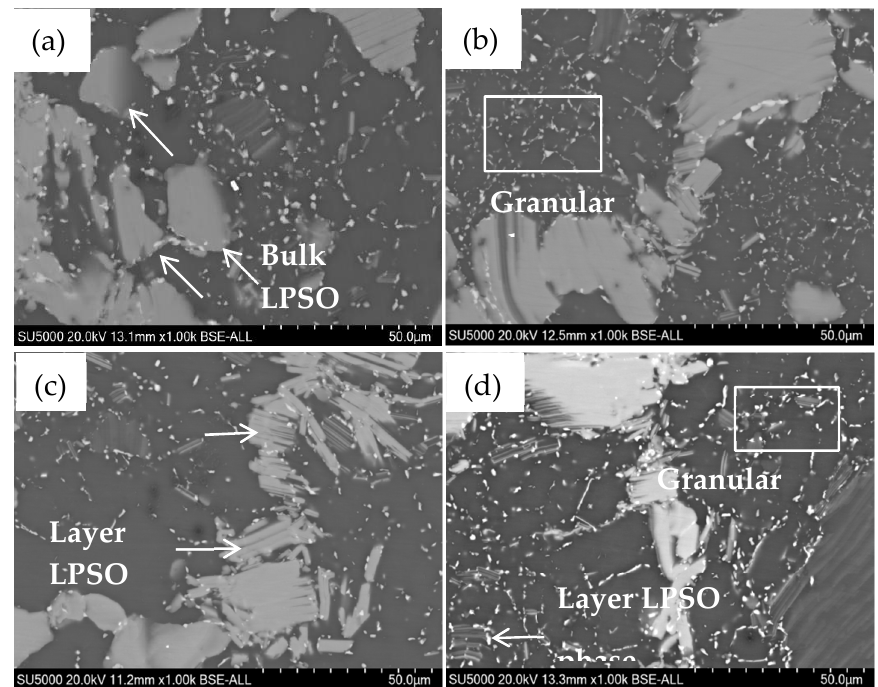
Figure 6. Scanning Electron Microscope (SEM) images of the alloy after different ageing treatments.